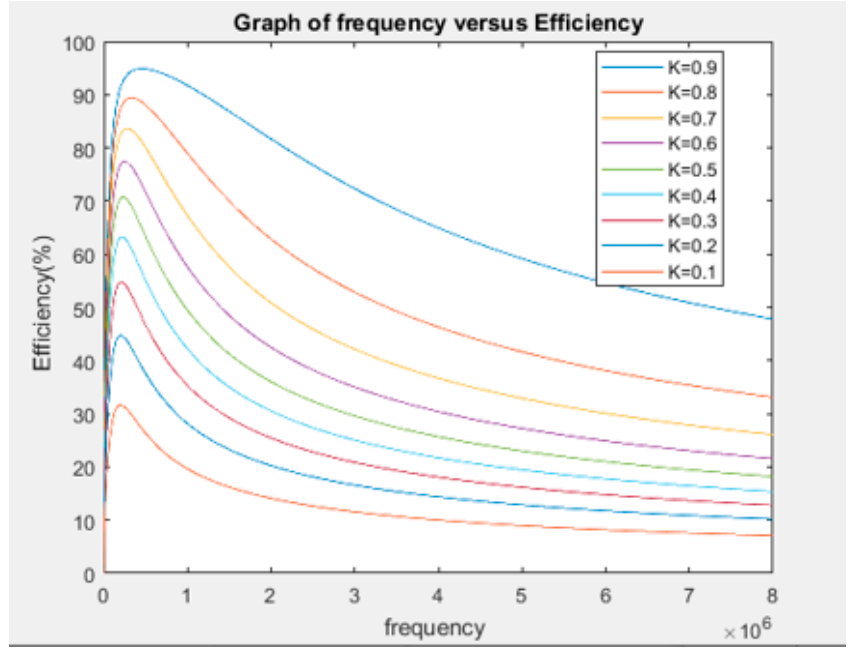
Figure 3. Effect of varying the coupling coefficient with respect to efficiency and frequency.